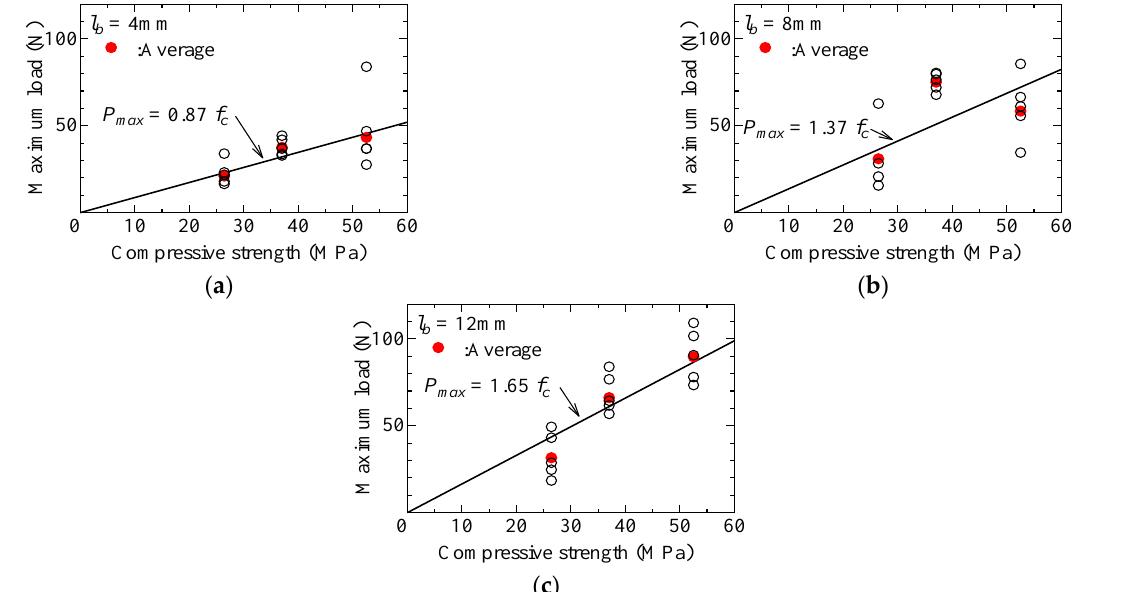
Figure 13. Relationship between maximum pullout load and compressive strength: ( a ) specimens with 4 mm embedded length; ( b ) specimens with 8 mm embedded length; ( c ) specimens with 12 mm embedded length.